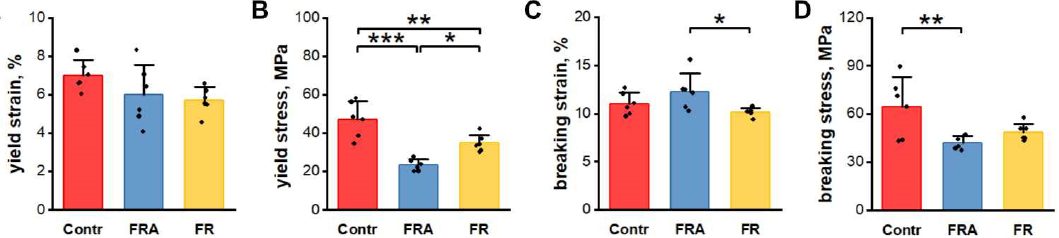
Figure 3. Mechanical properties of bone mid-diaphysis of femurs of animals in experimental groups. ( A ) yield force, ( B ) yield de fl ection, ( C ) elastic work, ( D ) sti ff ness, ( E ) breaking force, ( F ) breaking de fl ection, ( G ) breaking work. Bar plots show mean values and standard errors. A range of p -values has been assigned above plots where two groups show signi fi cant di ff erences: * p < 0.05, ** p < 0.01, *** p < 0.001.